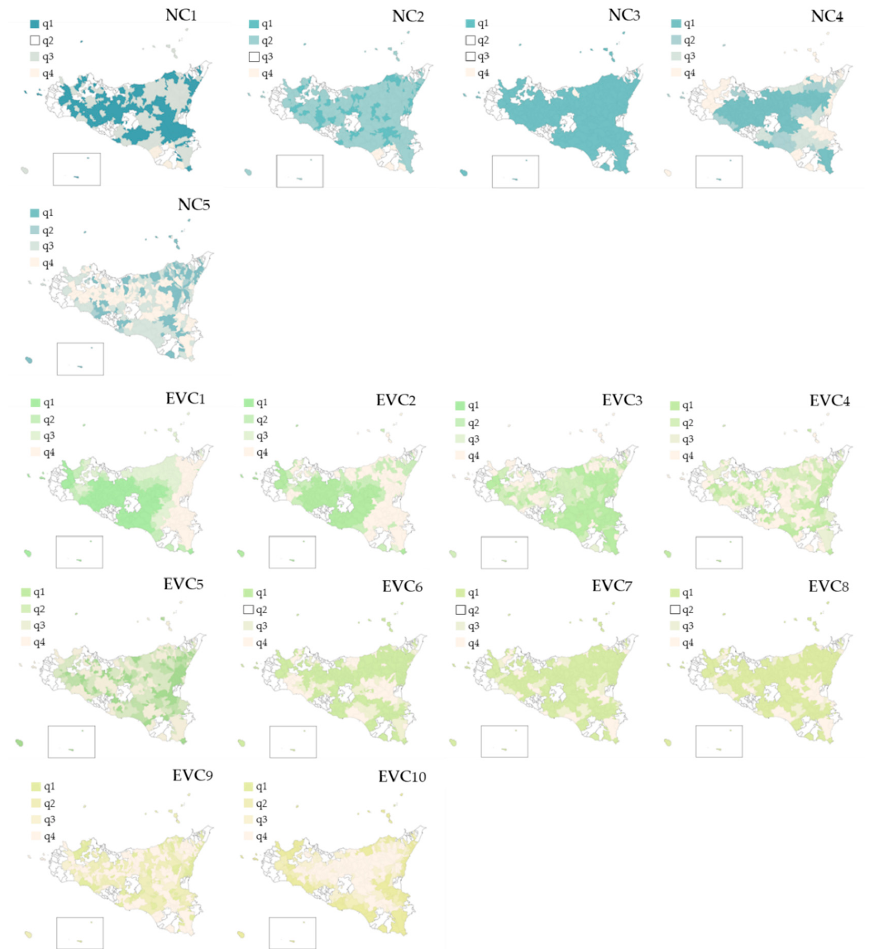
Figure 13. Mapping of Natural and Environmental Capital indicators. (Authors’